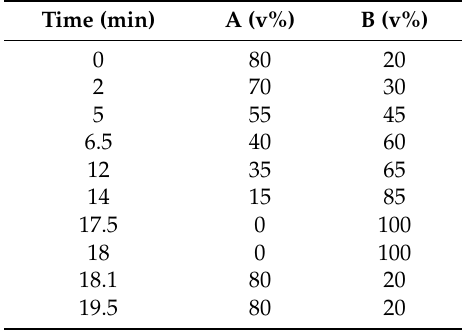
Table 2. The gradient conditions for reversed-phase C18 separation for lipid.